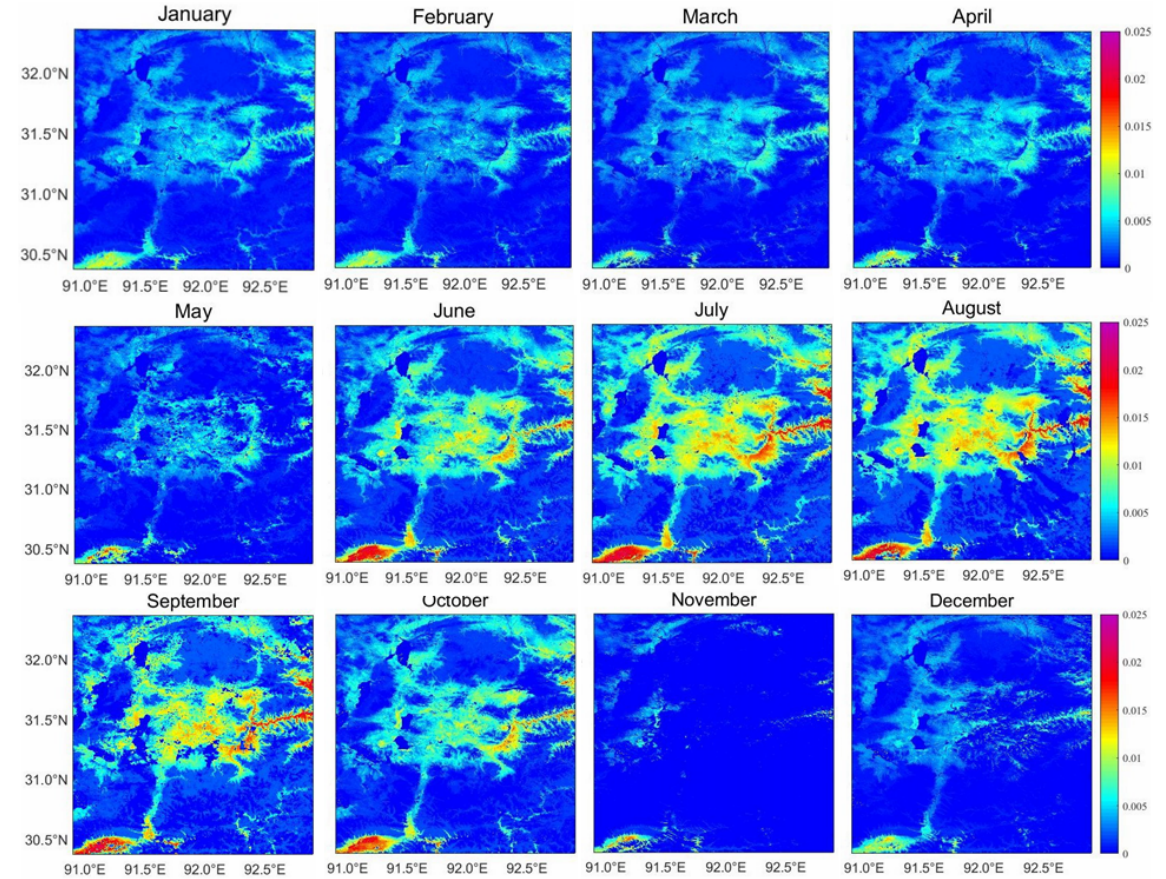
Figure 3. Surface roughness length on the northern Tibetan Plateau in